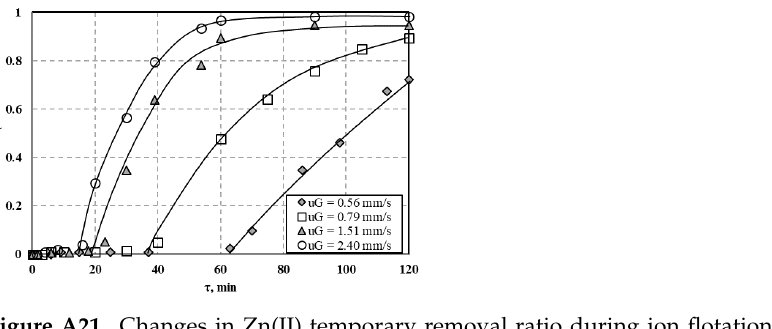
Figure A20. Changes in Cu(II) temporary removal ratio during ion flotation from solution con- taining Al(III), Cu(II), and Zn(II) mixture—effect of air velocity (c 0 = 0.15 mmol dm − 3 , pH = 3.0, c SDS = 1.186 mmol dm − 3 ).